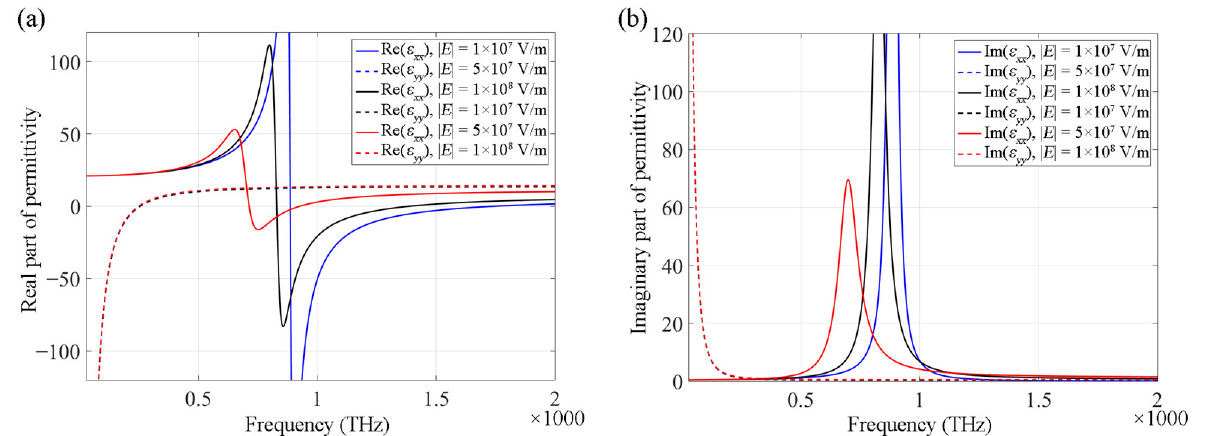
Figure 6. Change of transverse and longitudinal components of permittivity according to different field intensities in nonlinear regime. ( a ) and ( b ) are the real and imaginary parts of the permittivity, respectively.